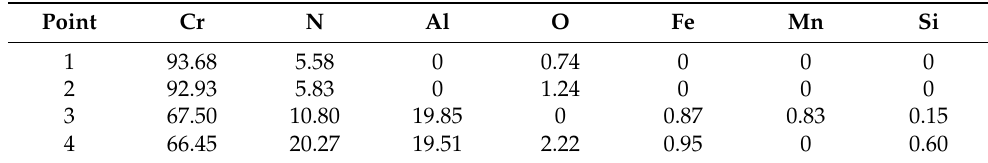
Figure 11. SEM microscopic morphology of impact wears scar at 500 ◦ C in no sand. ( a ) CrN coating, and ( b ) CrAlN coating. Table 1. The chemical compositions of